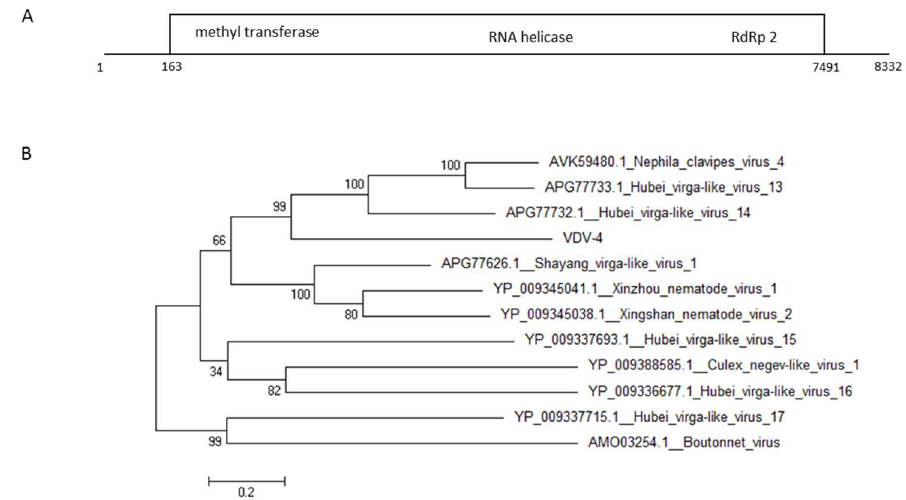
Figure 5. Genomic organization ( A ) and maximum-likelihood phylogenetic tree ( B ) of VDV-4. The tree was constructed based on the ORF of VDV-4. GeneBank accession numbers provided.